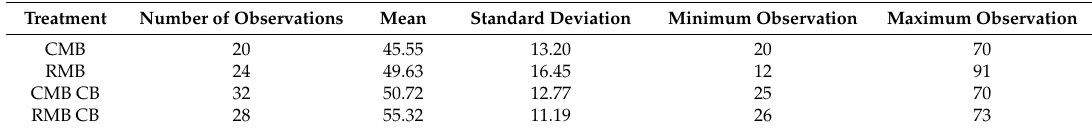
Table 2. Total Group Contributions to the Group Project.